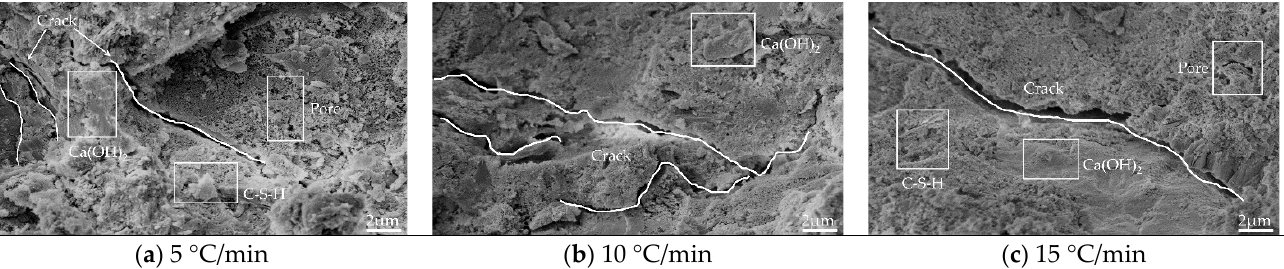
Figure 10. Microtopography and pore structure images of mortar heated (500 °C): ( a ) 5 °C/min; ( b ) 10 °C/min; ( c ) 15 °C/min.